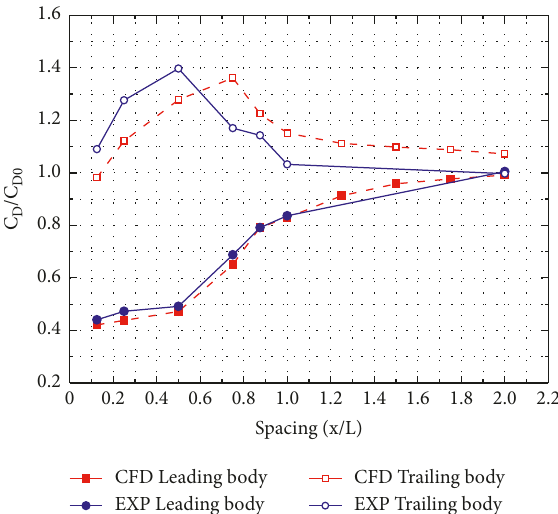
Figure 6: Normalized drag coefficient C single body) of two Ahmed bodies under different inter-vehicle